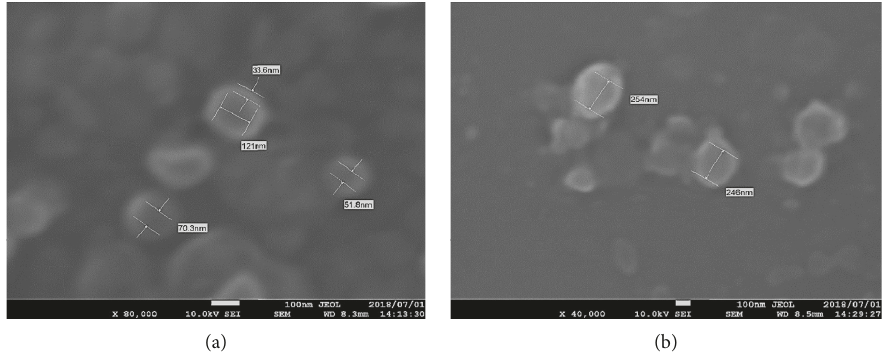
Figure 5: FESEM image of (a) Au@PZT in water and (b) PZT@Au in PVP.